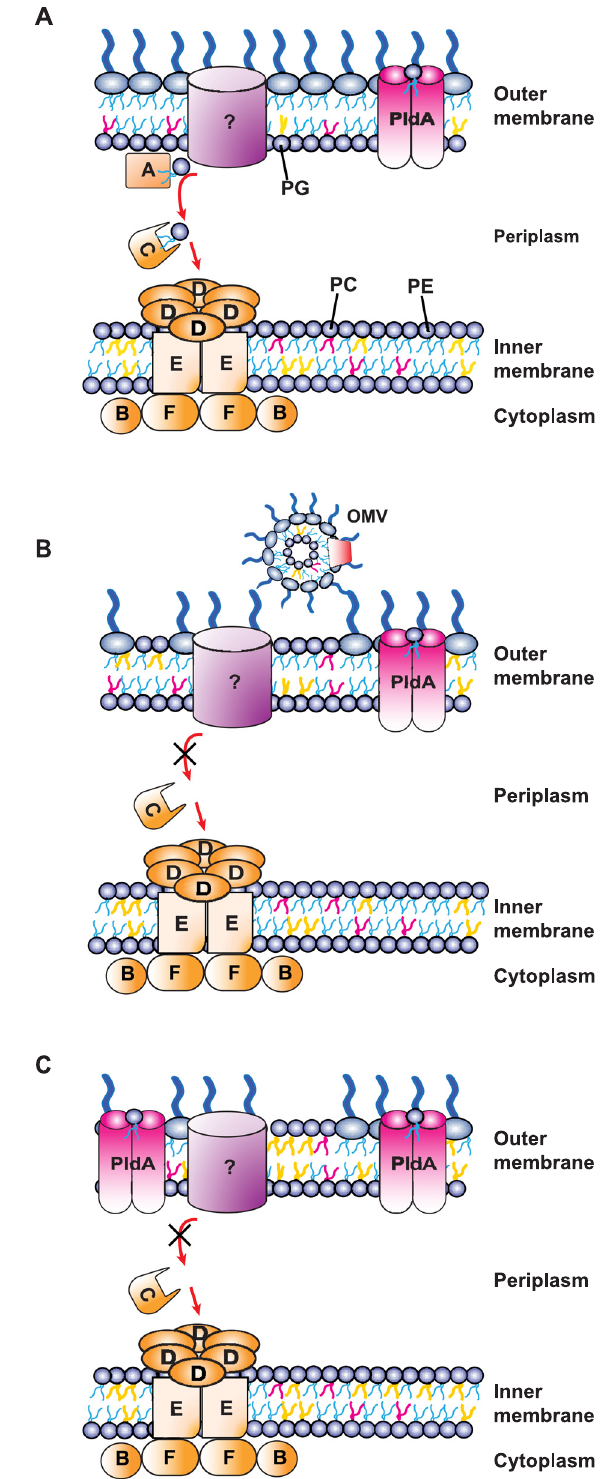
Fig 1. Model of phospholipid homeostasis systems in N . gonorrhoeae . (A) In WT N . gonorrhoeae , MlaA, potentially interacting with an unknown partner, participates in retrograde trafficking of phospholipids from the outer leaflet of the outer membrane, through the periplasmic component of the system, MlaC, to the inner membrane MlaBDEF complex. The phospholipase PldA dimerizes to its active form upon detection of mis-localized phospholipids and